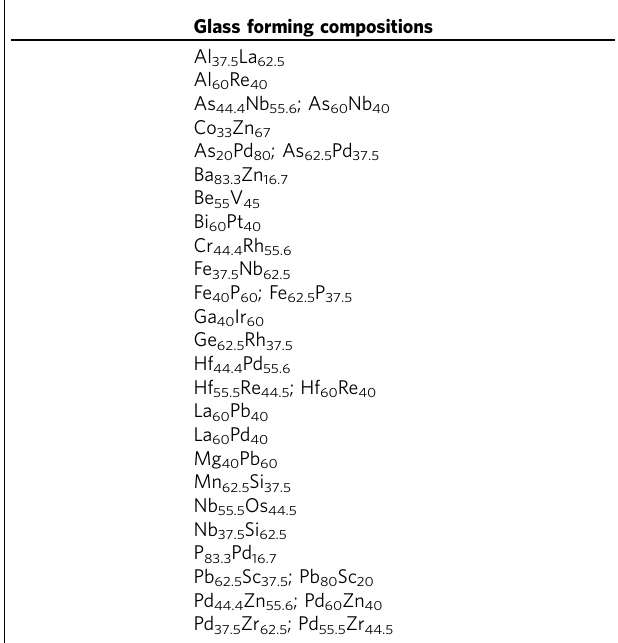
List of 16 reported glass-forming alloys used for training the spectral descriptor. Whenever a broad glass-forming region was reported we counted two peaks, one at the beginning of the region and one at the end. This approach leads to a total of 26 peaks used as references. An emptyentryat the secondcolumnmeansthat noglass-formingcompositionwaspredicted, that is, a miss. Thesecond column includes both peaks that correspond to the reported ones, as well as a few that do not correspond to any of the reported glass-forming alloys.